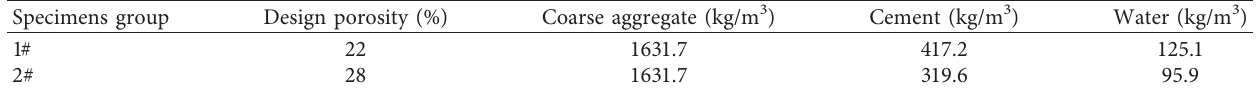
Table 3: Compositions of pervious concrete.